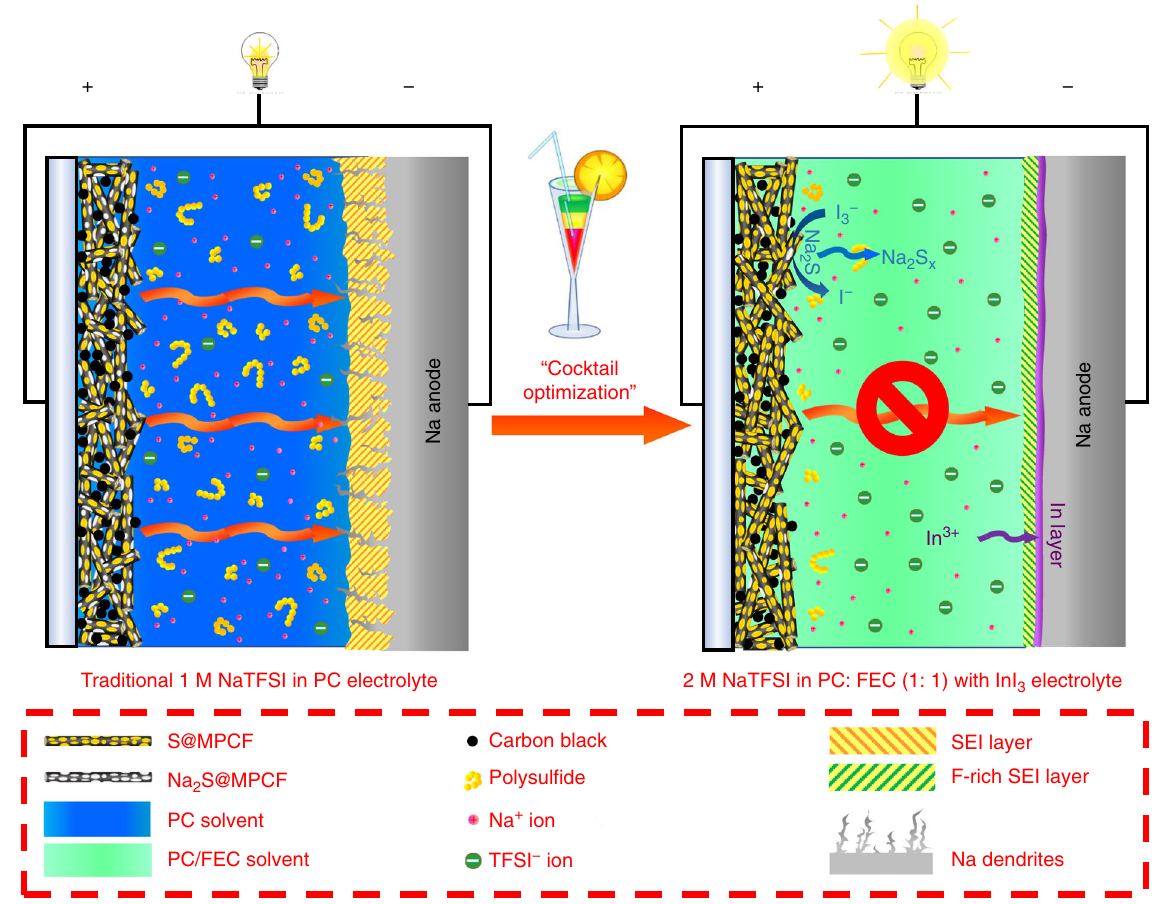
Fig. 1 Schematic illustration of room-temperature Na – S batteries using (left) conventional 1 M NaTFSI in PC electrolyte and (right) 2 M NaTFSI in PC: FEC (1:1 by volume) with 10 mM InI 3 additive